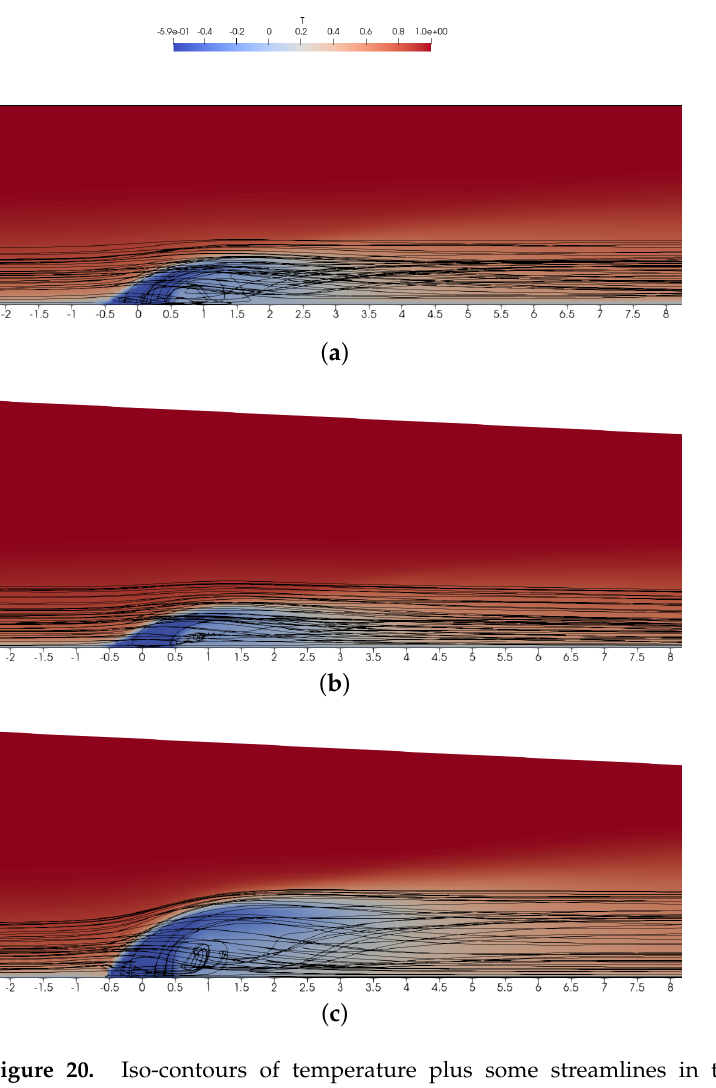
Figure 20. Iso-contours of temperature plus some streamlines in the centerline plane YX .